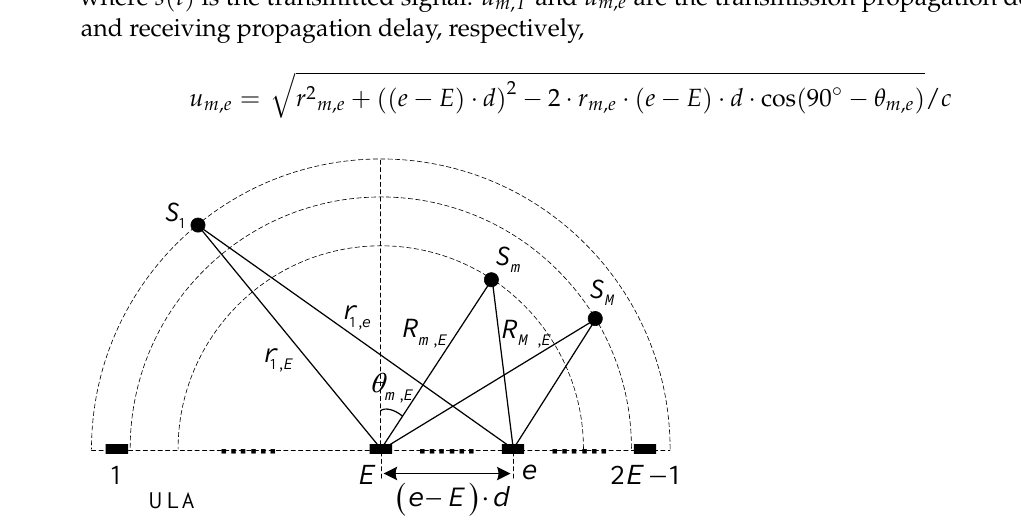
  Figure 9. Echo signal fitting algorithm. The doppler effect is also an inevitable problem in a high − speed acoustic mapping system, which refers to the signal frequency offset caused by the relative motion between